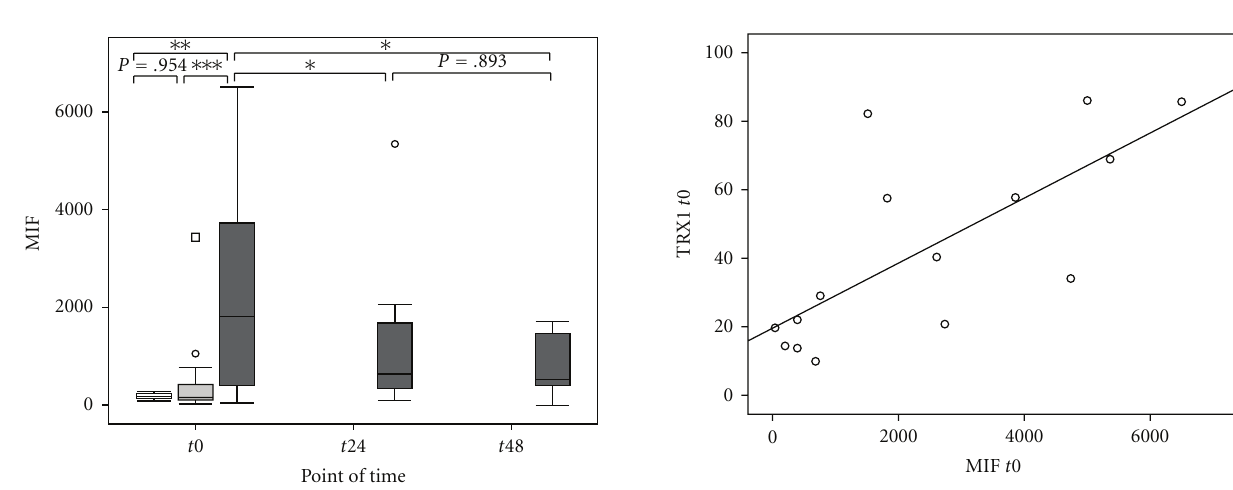
Figure 3: Comparison of Macrophage Migration Inhibitory Factor (MIF) measurements in the volunteer, postoperative, and septic groups at baseline and at 24 and 48 hours in the septic group. Concentrations of Macrophage Migration Inhibitory Factor (MIF; (pg/ml)) were measured from the sera of healthy volunteers (“Healthy,” n = 18, white box), postoperative patients after major abdominal surgery (“Post-OP,” n = 28, light grey box), and patients with sepsis (“Sepsis,” n = 15, dark grey box), at t 0 (measured once for the volunteer group, immediately after surgery for the postoperative group, and at the time of diagnosis of sepsis for the sepsis group). In addition, for the septic group, the two other times of data collection are represented, t 24 and t 48 for 24 and 48 hours, respectively, after the diagnosis of sepsis. Data in box plots is given as median, 25th percentile, 75th percentile, and the 1.5 interquartile range. Outliers are shown in form of circles (1.5–3 interquartile ranges above 75th percentile or below 25th percentile) or rectangles ( > 3 interquartile ranges above 75th percentile or below 25th percentile). Abbreviations: MIF, Macrophage Migration Inhibitory Factor.